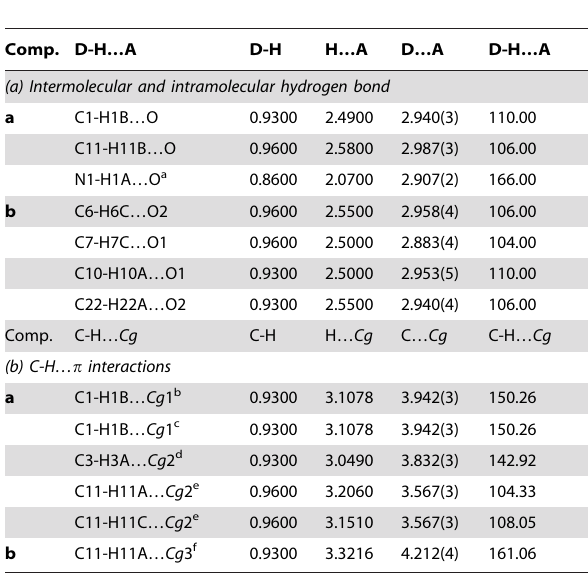
Table 2. Selected crystal structure parameters of a and b.